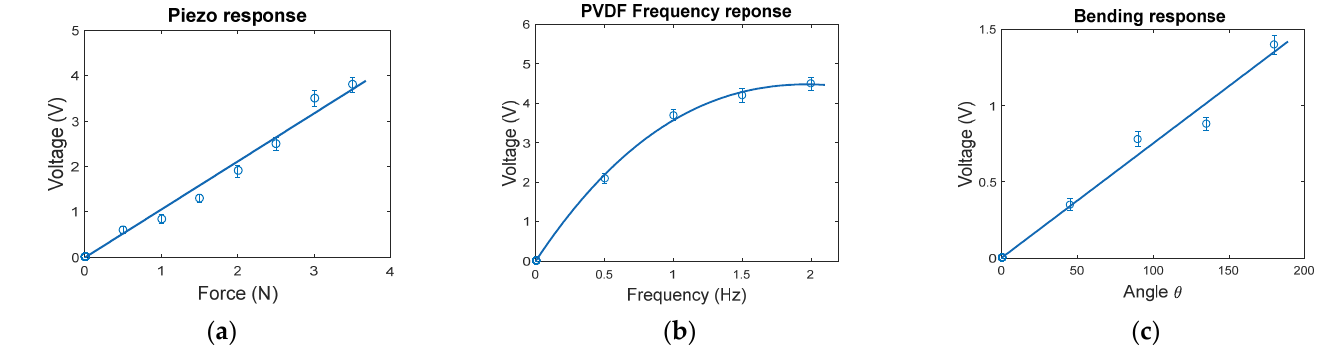
Figure 7. The Piezoelectric ( a ), frequency ( b ), and bending ( c ) response characterizations of the PVDF electrospun nanofibers.